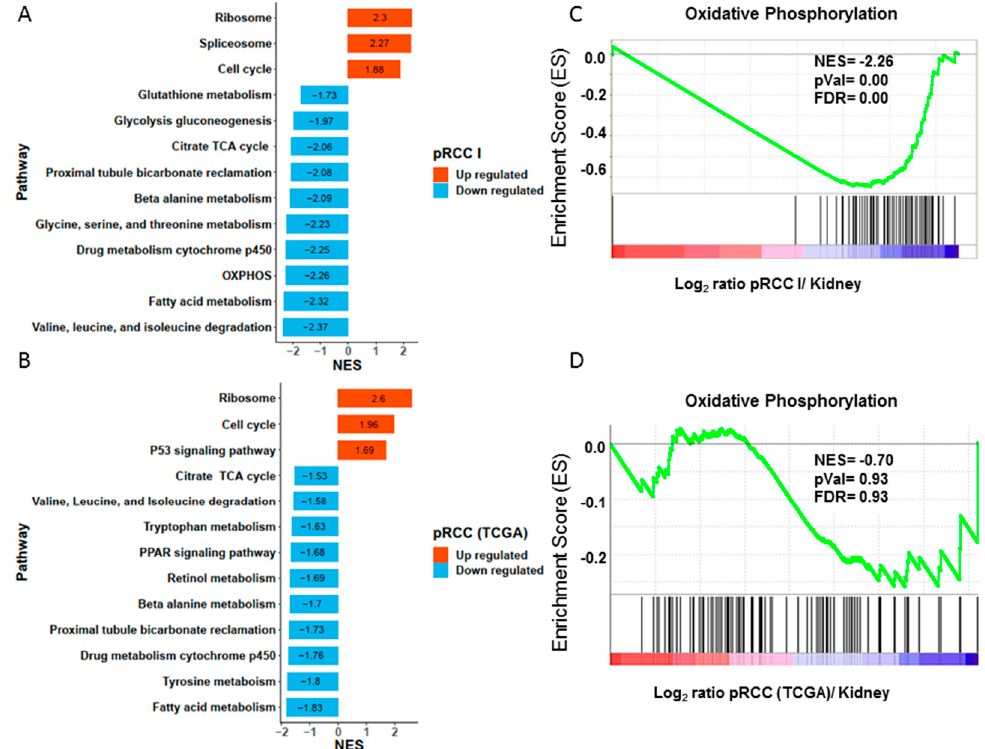
Figure 2. Significantly regulated Kyoto Encyclopedia of Genes and Genomes (KEGG) pathways between the proteomes of ( A ) papillary renal cell carcinoma (pRCC) type I and healthy kidneys and ( B ) of the transcriptome data retrieved from The Cancer Genome Atlas (TCGA). Shown is a collapsed list, the applied cutoff is p ≤ 0.05 and q ≤ 0.1. Specific enrichment plots for the KEGG pathway “oxidative phosphorylation” are shown for ( C ) the proteome and ( D ) the transcript data from TCGA. The Vacuolar-type H ± ATPases (V-ATPases) were removed from the pathway “oxidative phosphorylation” displayed in C and D, as they are wrongly assigned in this KEGG pathway. Normalized enrichment score, NES; Size, number of proteins/genes identified within a pathway.